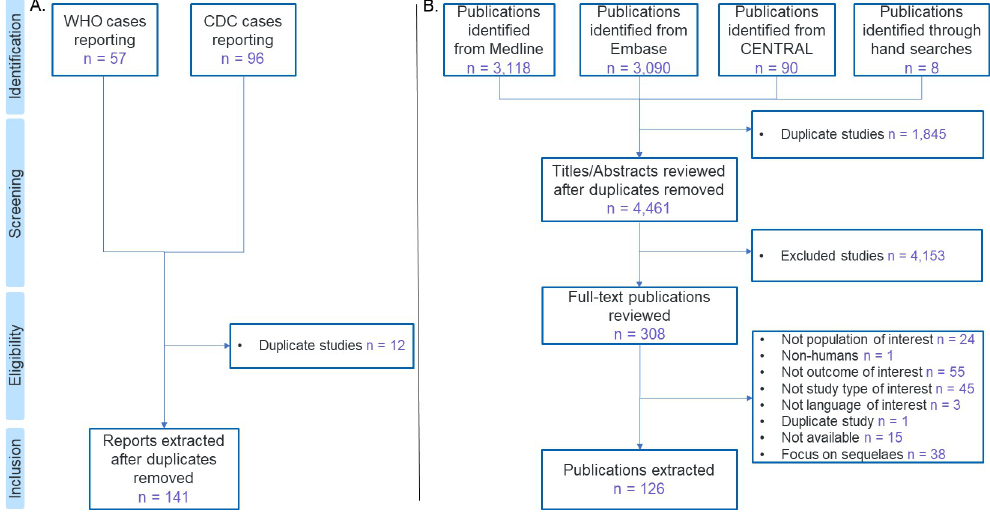
Fig 1. Study selection flow diagram: A. For the WHO and CDC websites search; B. For the systematic literature search.